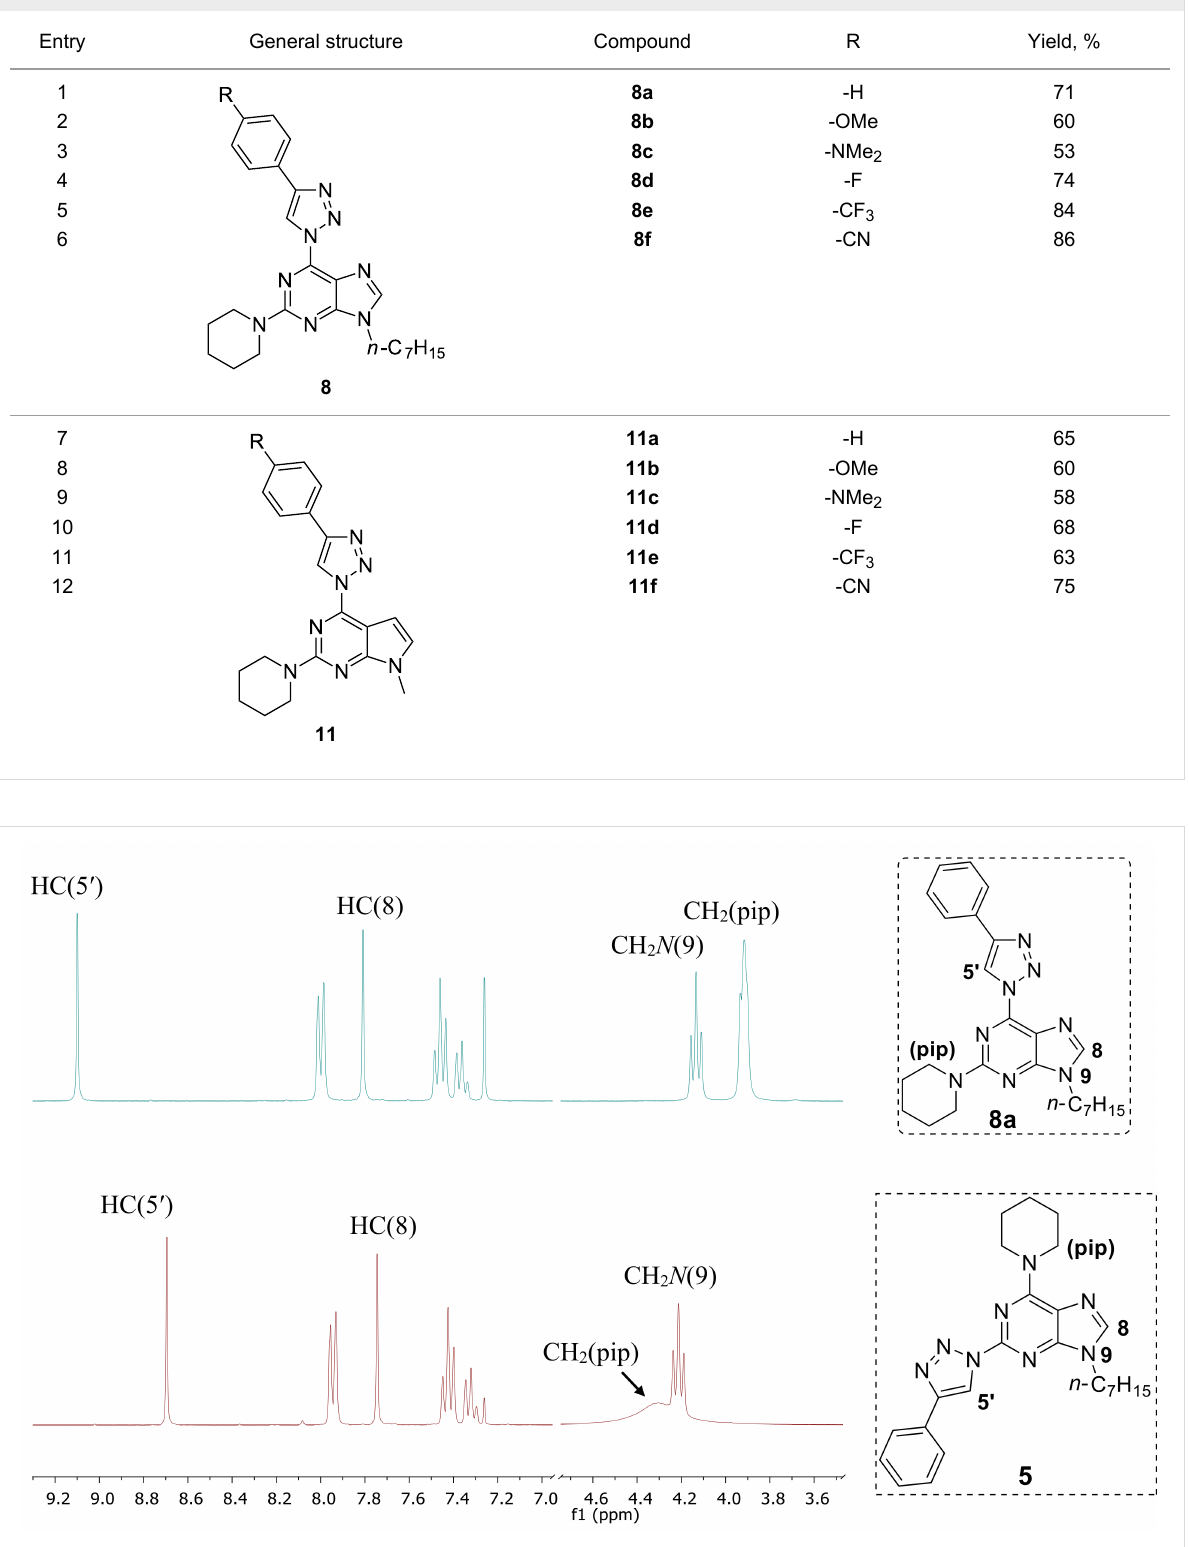
Figure 3: Comparison of 1 H NMR spectra of compounds 8a and 5 (300 MHz, CDCl 3